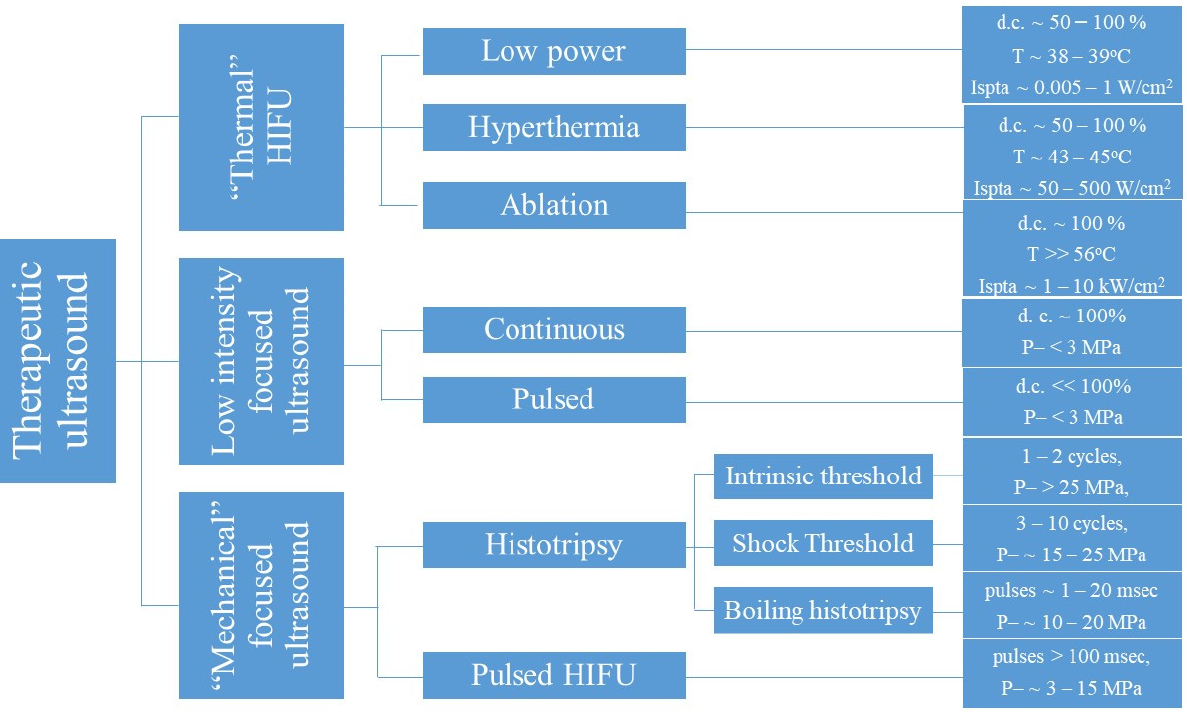
Figure 2. Therapeutic focused ultrasound can induce both “thermal” and “mechanical” effects on tissues.